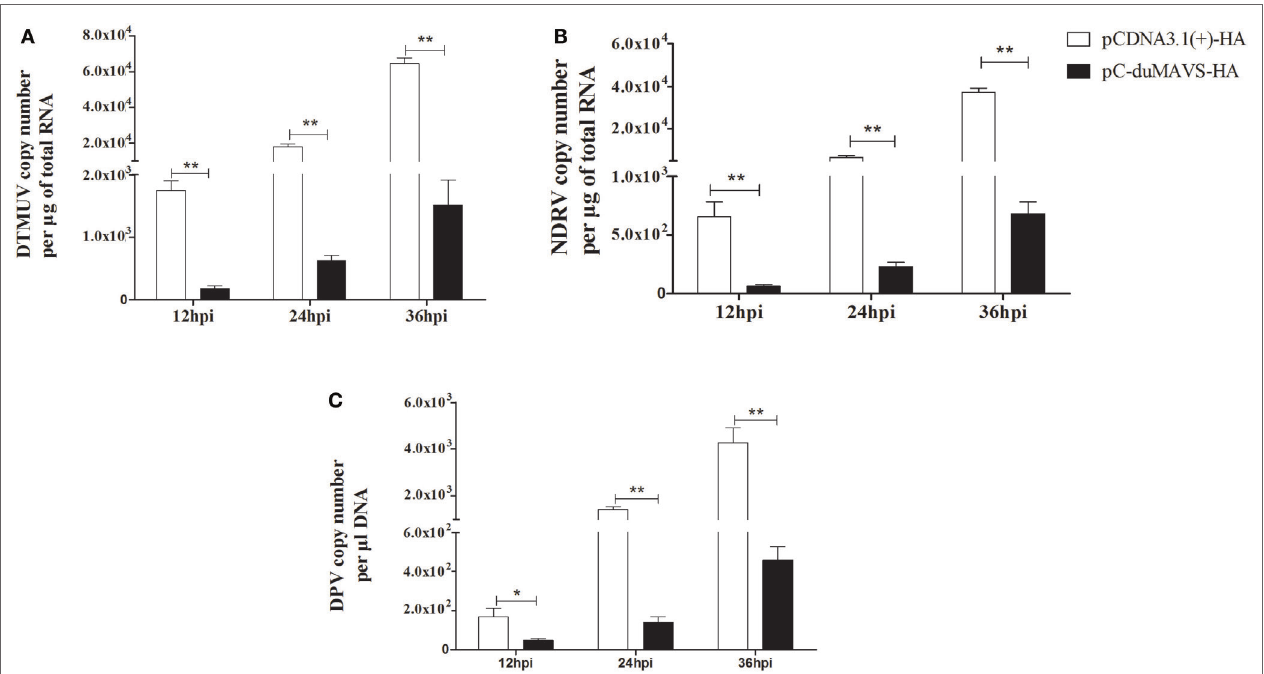
FigUre 6 | antiviral assays of duMaVs in DeFs . The empty vector and pC-duMAVS-HA were transfected into DEFs. At 24 hpt, the cells were infected with different viruses at 100 TCID 50 (a) DTMUV; (B) NDRV; (c) DPV. The culture supernatants were collected for detecting the viral titers at 12, 24, and 36 hpi using the RT-qPCR methods and data were repeated three times and each time was analyzed in triplicate. Student’s t test was performed to evaluate the differences. *Significant difference ( P < 0.05); **highly significant difference ( P <